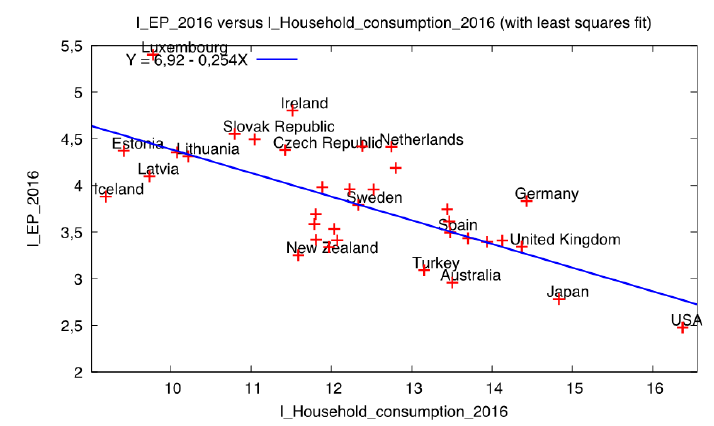
Fig. 2 – Scatterplot between Export performance and Household consumption. Source: own processing by UNCTAD (2018), Kaufmann & Kraay (2018), WBG (2018), Transparency International